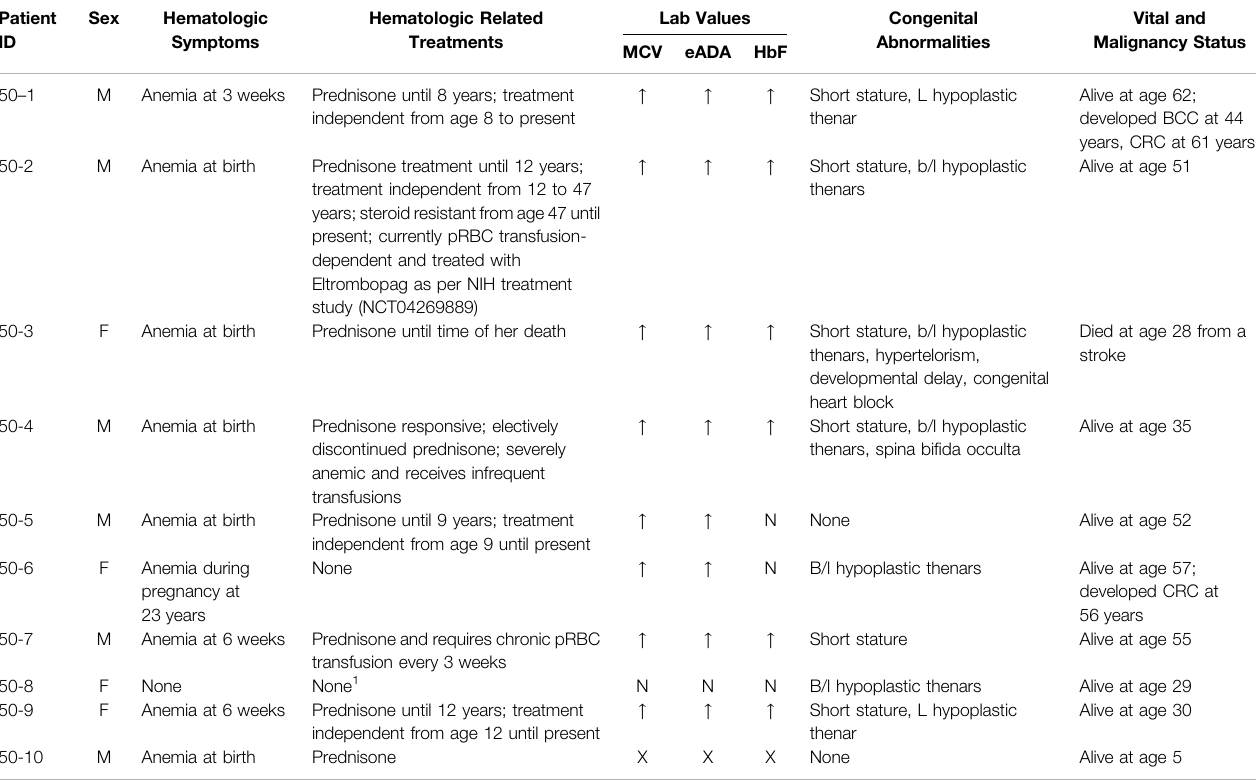
TABLE 1 | Clinical features of ten family members with Diamond Blackfan anemia due to a pathogenic heterozygous missense mutation in RPS19. Legend: Clinical informationisbasedonmedicalhistory questionaniresanddetailedmedicalrecord reviewonallcases. Cases50-1,50-2,50-3,and50-4werealso examinedatNIH by clinicians from ourstudy.Forlab values, uparrow ( ↑ )indicates elevated and Nisnormal. An eADA= > 0.96 EU/gmHb wasconsidered elevated,elevated MCV and HbF was based on > 2 SD from age and sex adjusted mean, and X indicates no available labs. Abbreviations: M=male; F=female; wks=weeks of age; yrs=yrs of age; BCC=basal cell carcinoma; CRC=colorectal cancer; pRBC=packed red blood cells; NIH=National Institutes of Health; MCV=mean corpuscular volume; eADA=erythrocyte adenosine deaminase; HbF=fetal hemoglobin; L=left; b/l=bilateral. 1 Last medical record available was at age